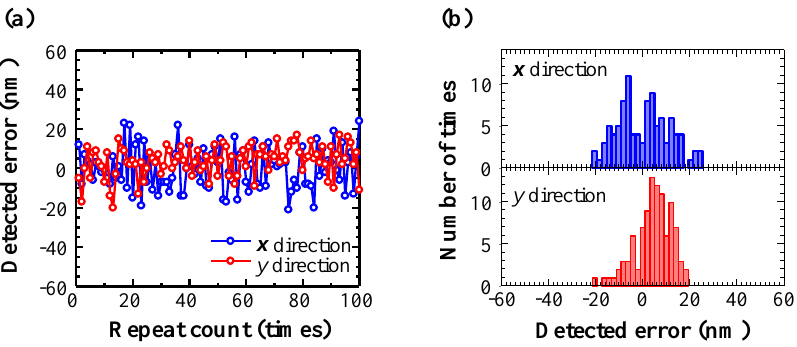
Figure 4. Evaluation of detection accuracy of image recognition technique: ( a ) Obtained read-out deviation in time; ( b ) Histogram of the detected error values.